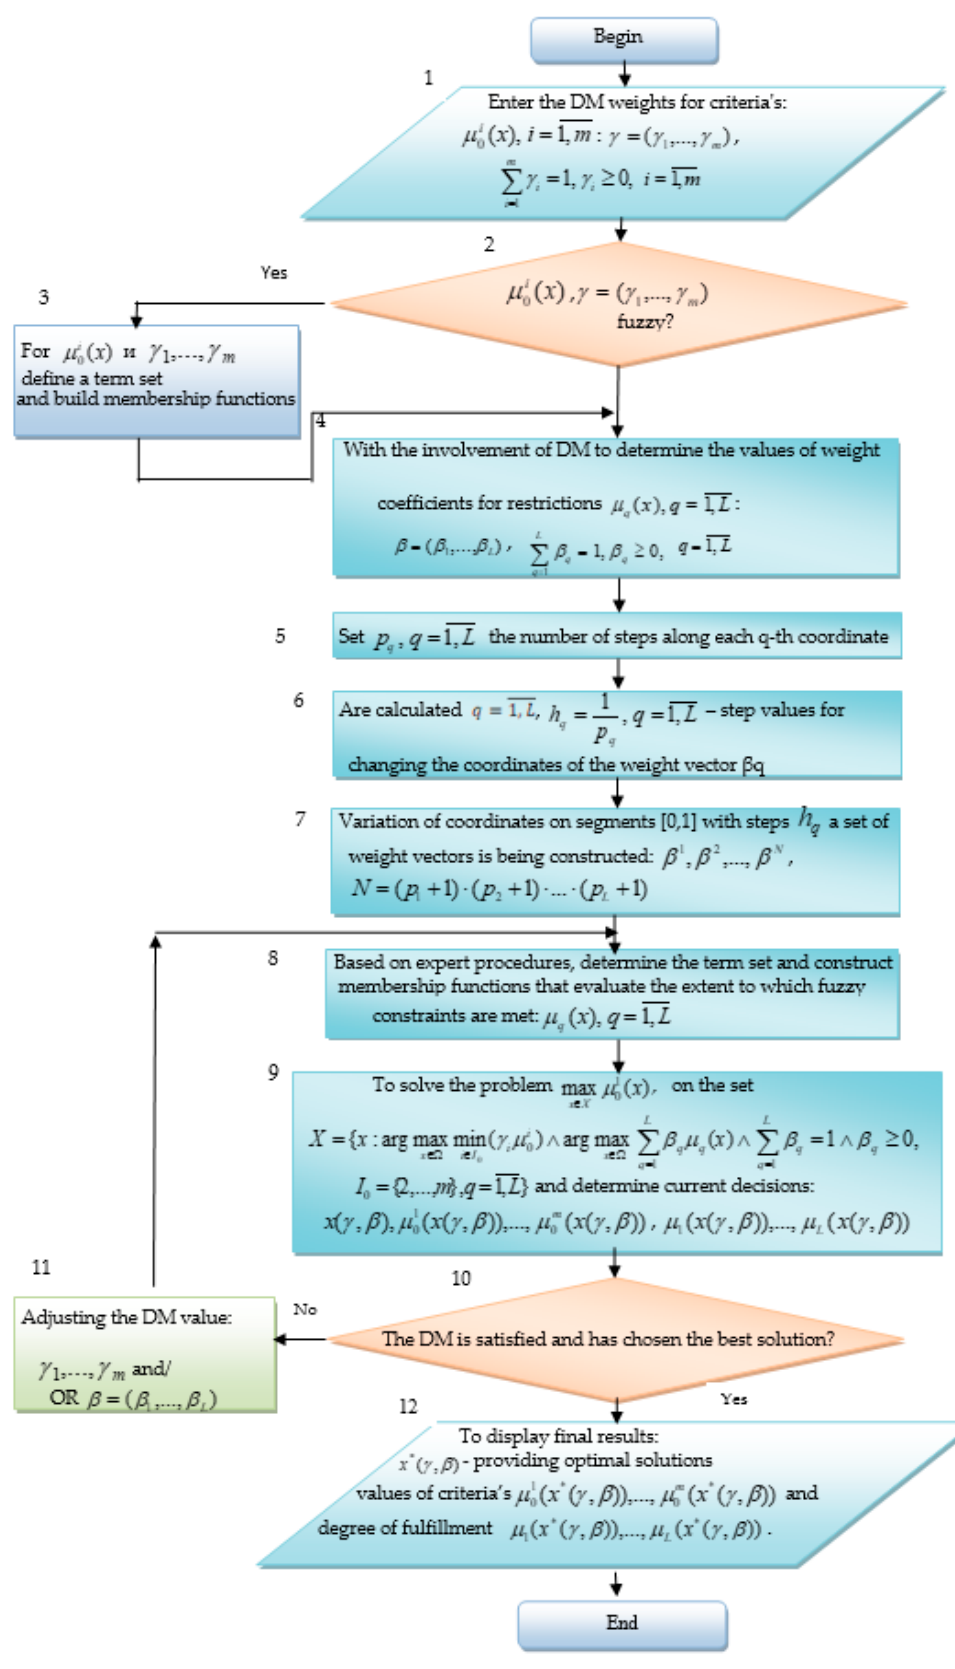
Figure 1. Flowchart of a heuristic algorithm based on the principles of MM +